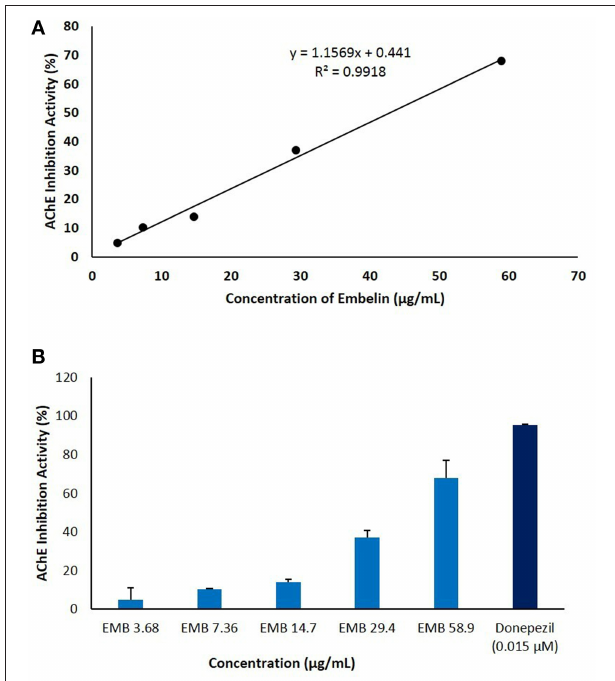
FIGURE 3 | The anti-cholinesterase activity of embelin (3.68–58.9 µ g/mL) using in vitro AChE inhibitory assay. The graph was plotted by keeping embelin concentration on X-axis against AChE inhibition activity (%) on Y-axis. (A) IC 50 value was calculated using standard curve generated using Microsoft Excel. (B) AChE inhibitory activity (%) of embelin compared to